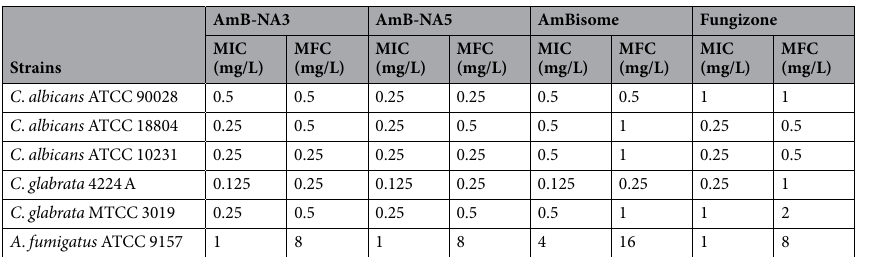
Table 6. In vitro antifungal activity of various AmB formulations.